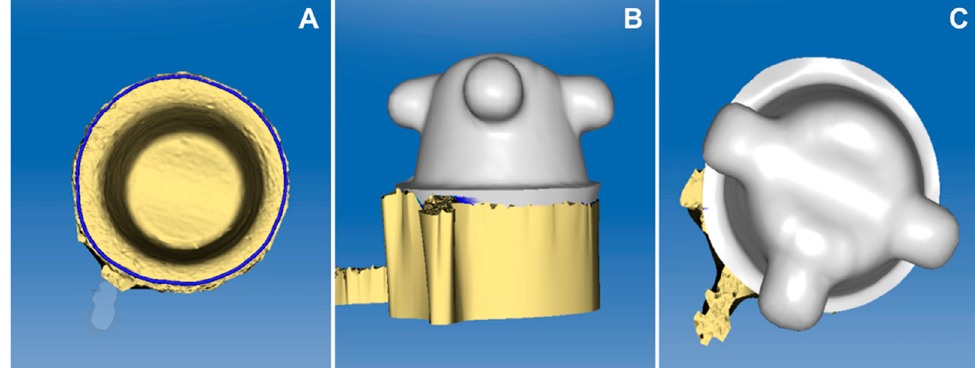
Figure 3. The images represent a CAD (computer-aided design) process: ( A ) delimitation of the cervical edge of the preparation; ( B ) preparation coping design (front view); and ( C ) preparation coping design (upper view).